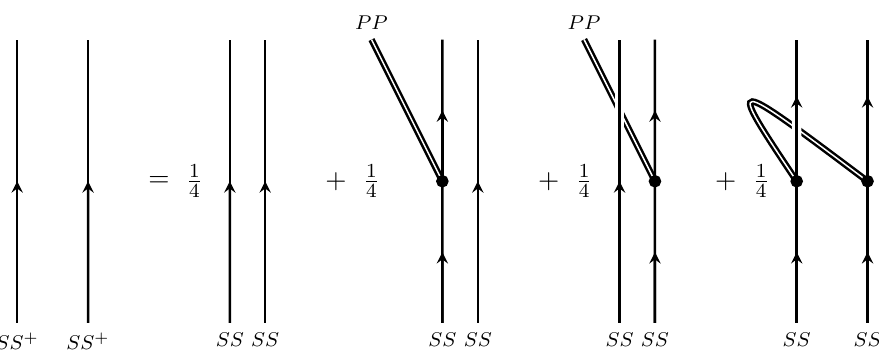
Figure 31 . Computation of SS + (cid:10) SS + is by de(cid:12)nition a sum of four terms which involve associators and crossings. II inside SS (cid:10) SS is mapped to II by (cid:12)rst and fourth terms and to PP (which is isomorphic to II in the new category) by the second and third terms. Similarly, PI is mapped to the zero object as the four terms cancel in pairs. Hence, SS + (cid:10) SS + ’ II . S if (cid:26) ( g ) = 1. The fusion rules and associators are just pulled back from I g 1